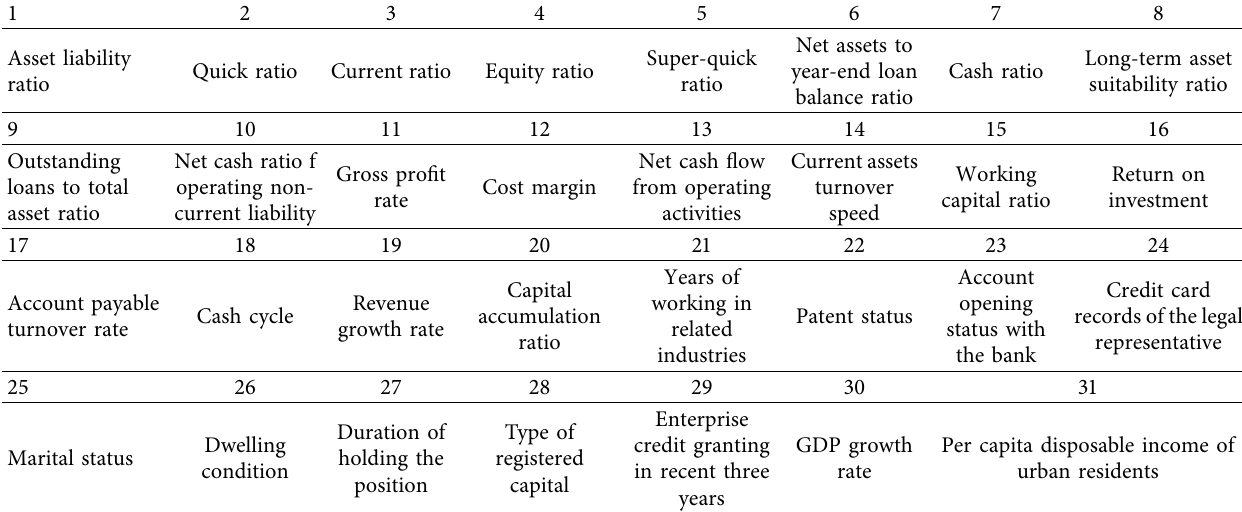
Table 6: The rank of performance of CNN and other four models on C